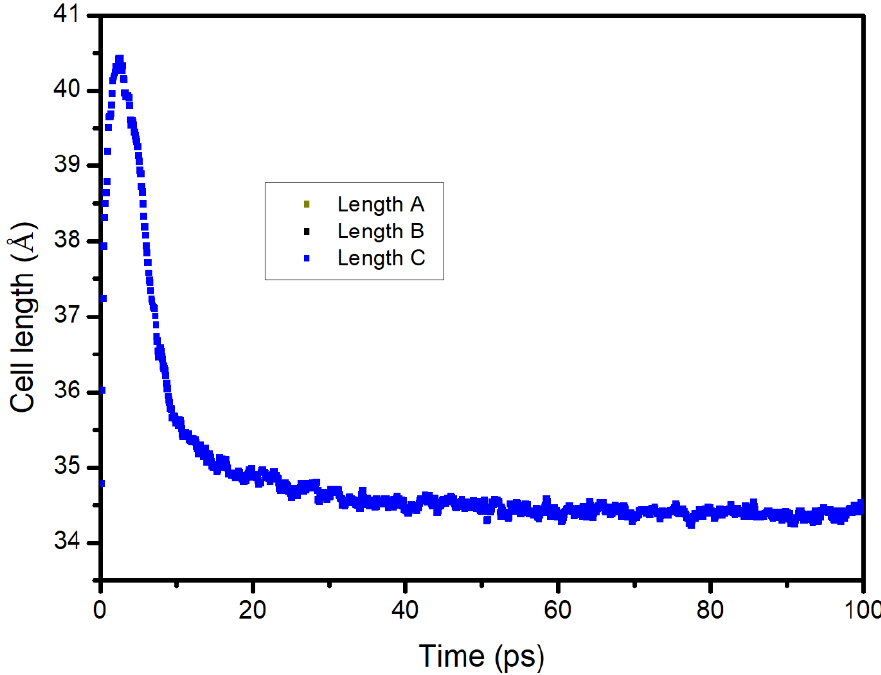
Figure 16. Change in the system volume with time during the diffusion process of sunflower oil in the asphalt.